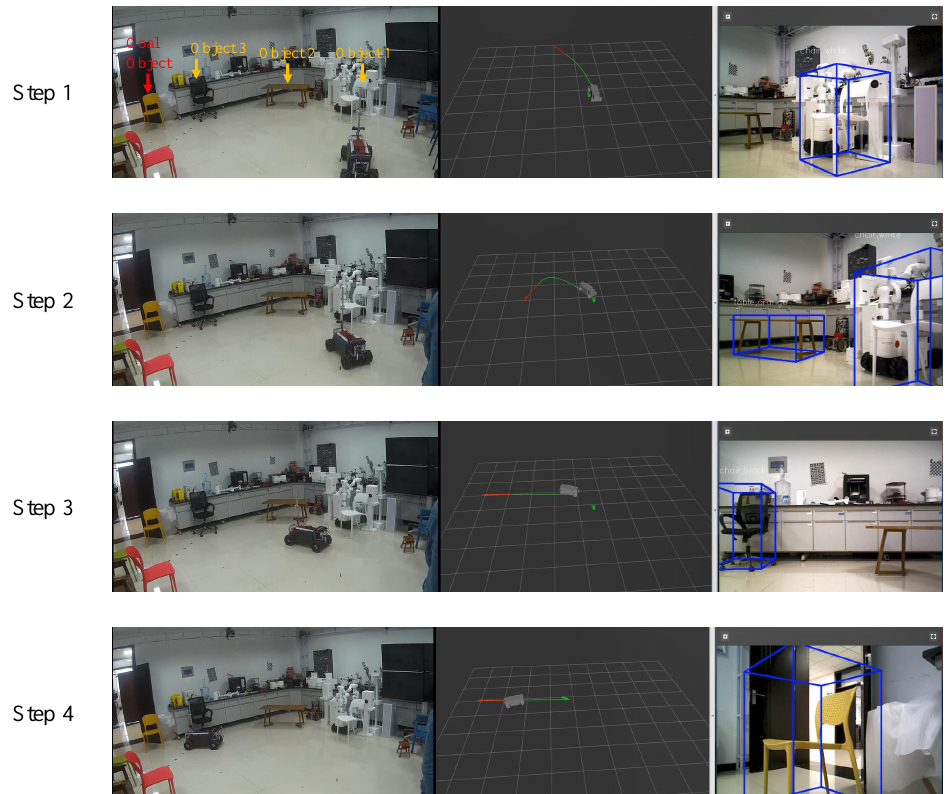
Figure 20. Visualization results for navigation in the S1 scene. We select an object-level topological path after constructing the lightweight topological semantic map. Then, the robot is guided from step one to step four to generate a segmented smooth trajectory to the next invisible object based on the currently visible object until it moves within 1 meter of the goal object and publishes an “arrived” command to end the navigation.